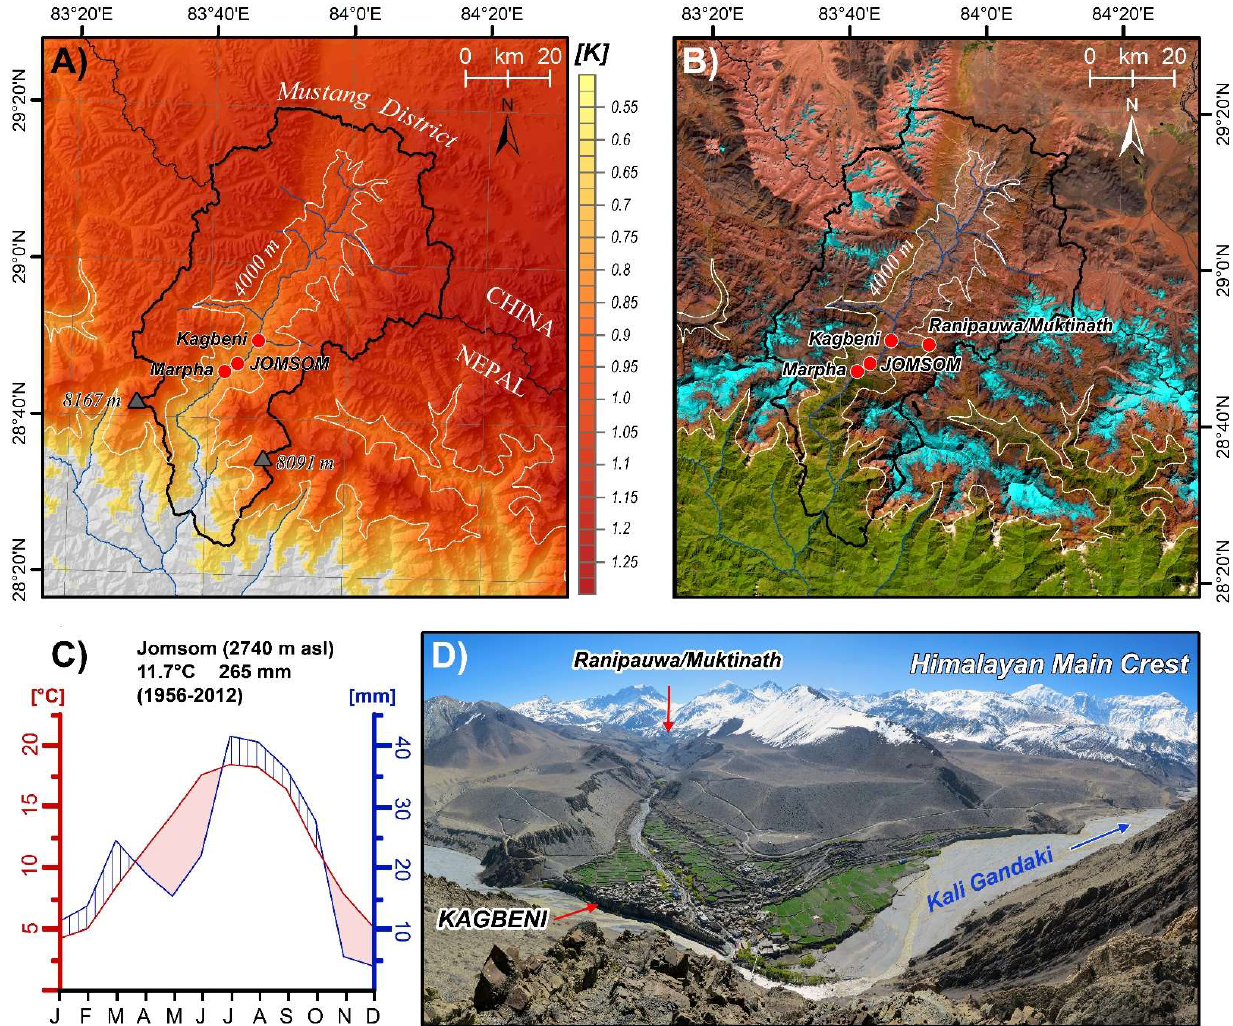
Figure 2. ( A ) Trends in mean annual temperature [in K] calculated from the CHELSA reanalysis data [45] for the period 1979–2013. Only significant trends ( p < 0.01) are shown. ( B ) Satellite Imagery of the investigation area (Operational Land Imager band composites 6,5,4; acquisition date: October 16, 2020) with blue colors indicating snow and glacierized areas. ( C ) Climate diagram for Jomsom and ( D ) photograph towards the settlement of Kagbeni (6 April 2018). Green colors indicate fields with germinated winter barley on the irrigated fields.